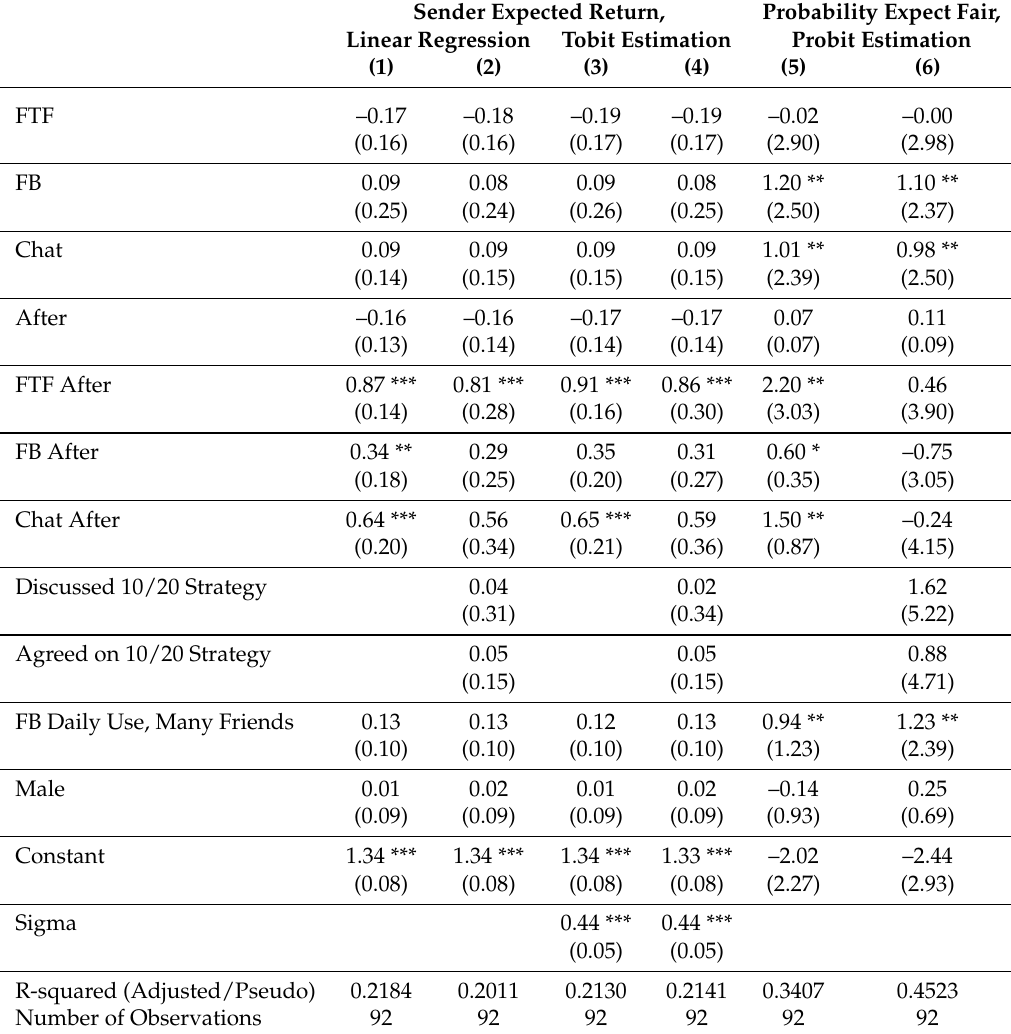
Table 4. Sender expected return on amount sent: regression